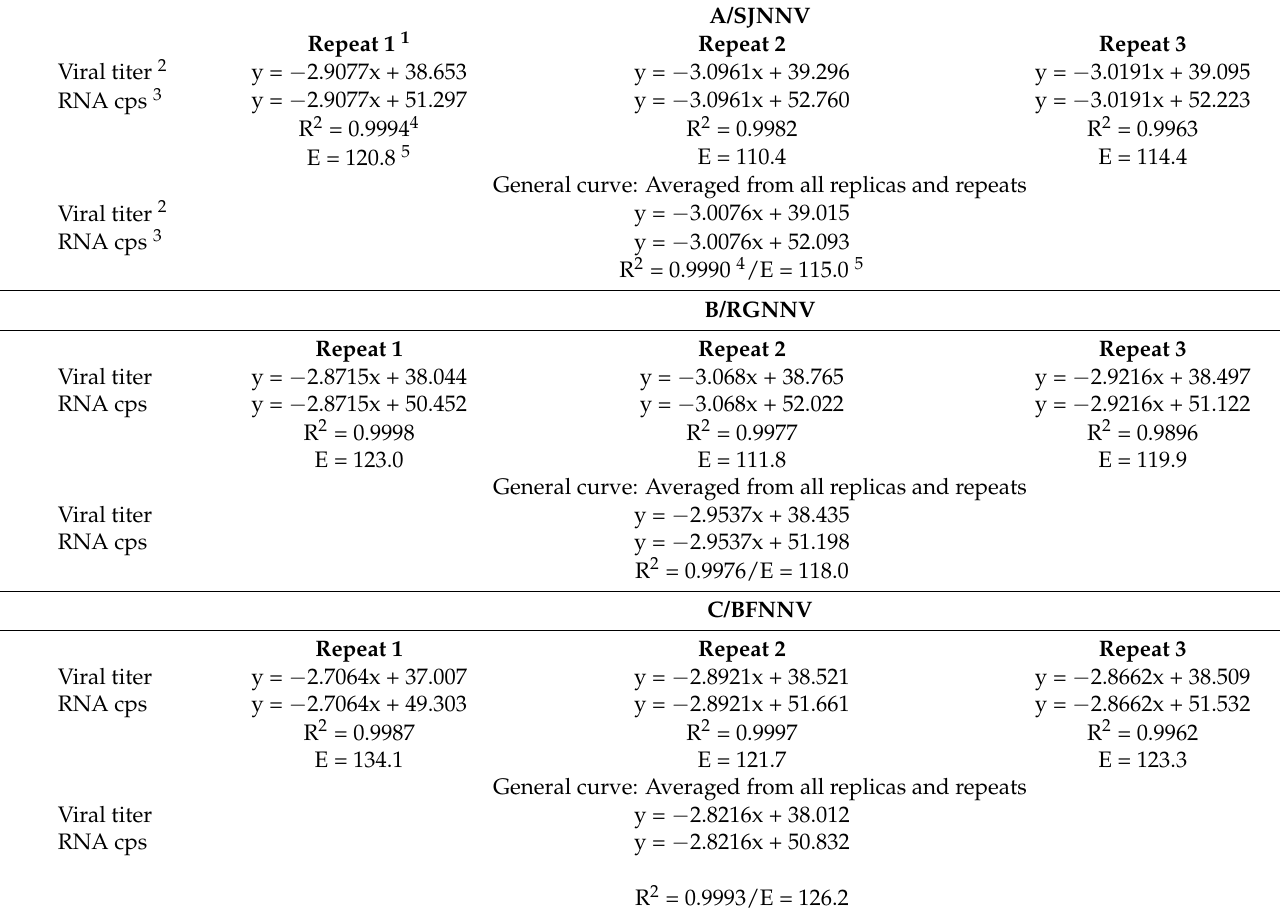
Table 3. Reliability of the quantification using crude virus as standard.